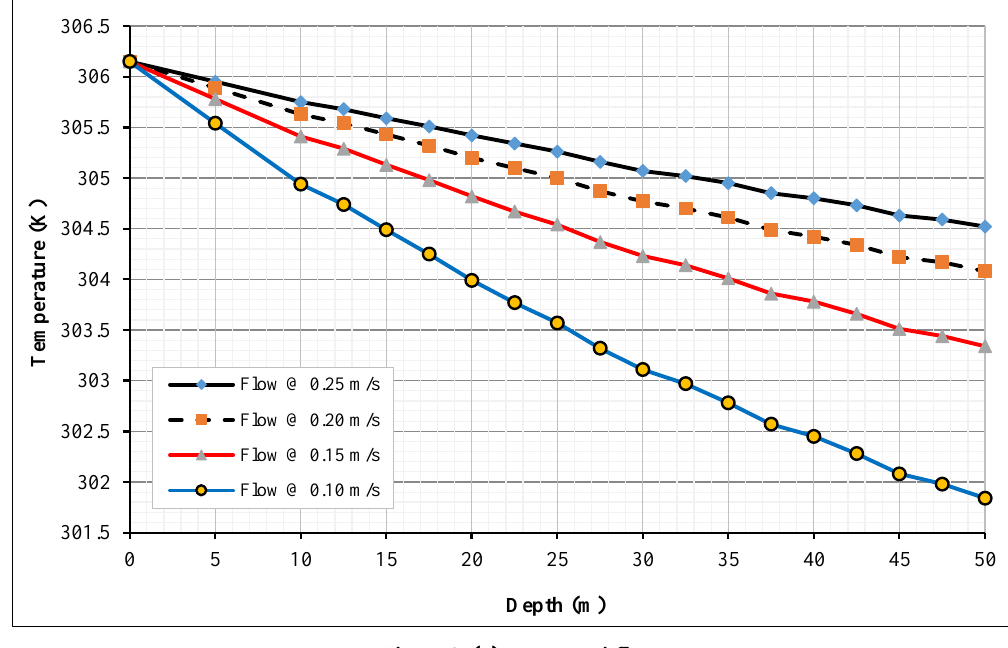
Figure 6. (a) Downward flow